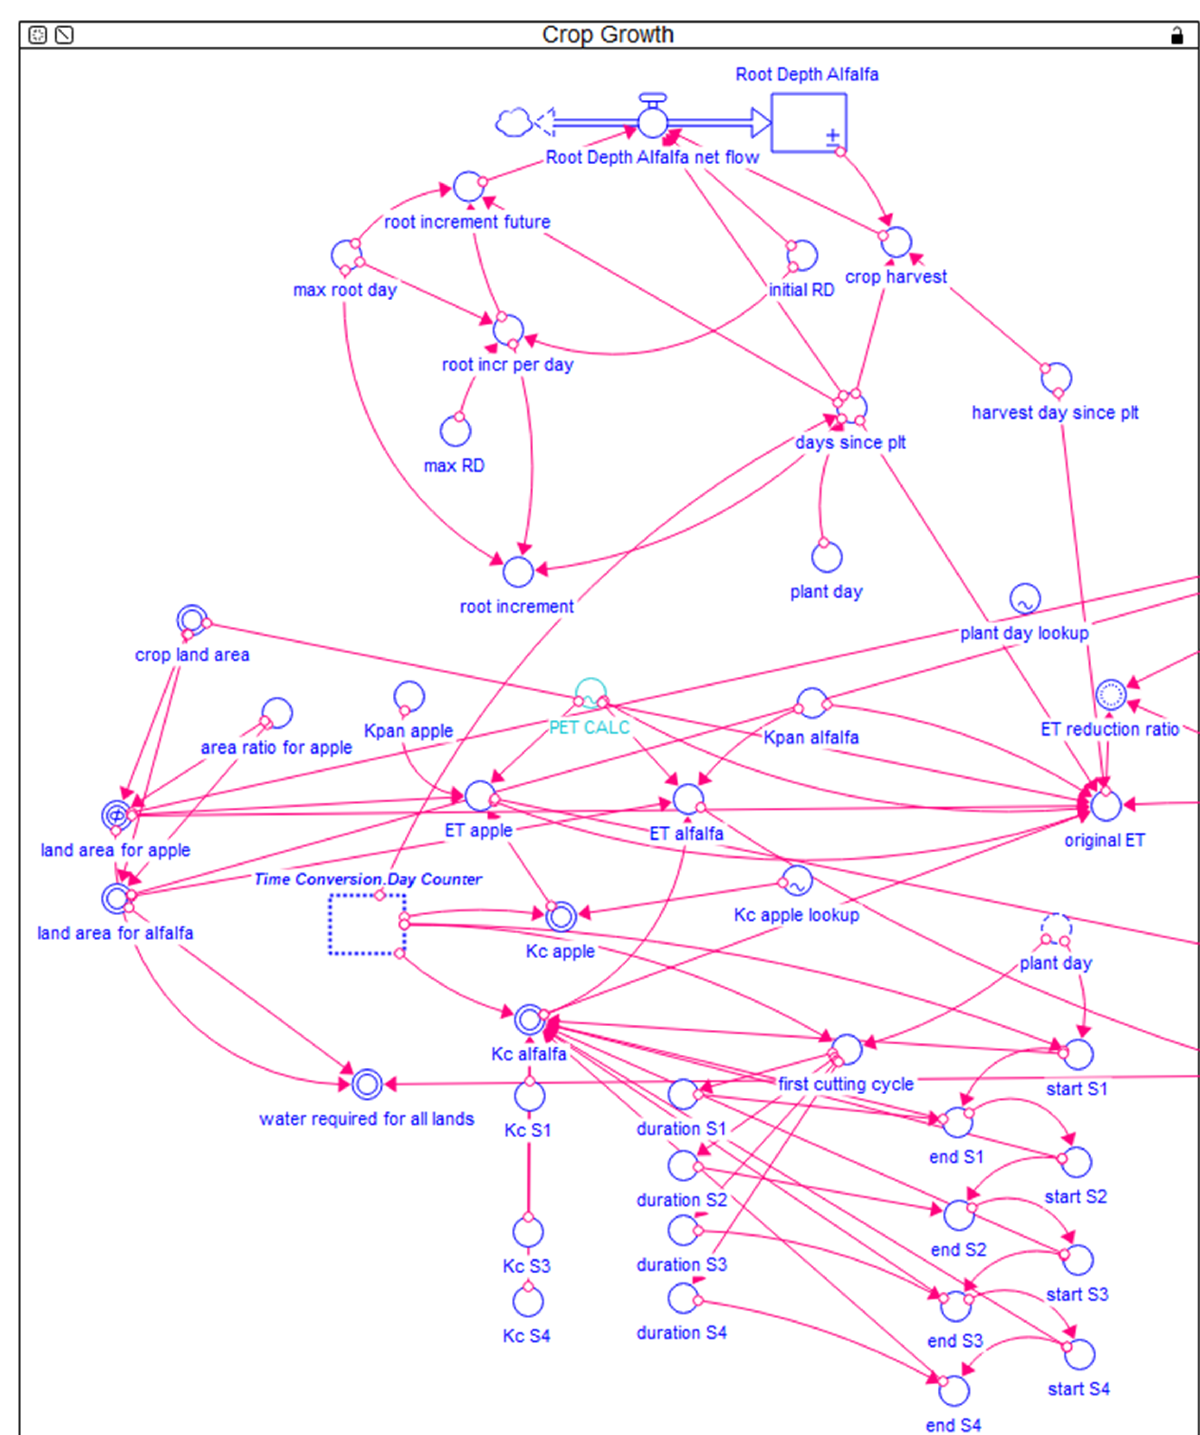
Figure A5. System dynamics model structure for crop growth.